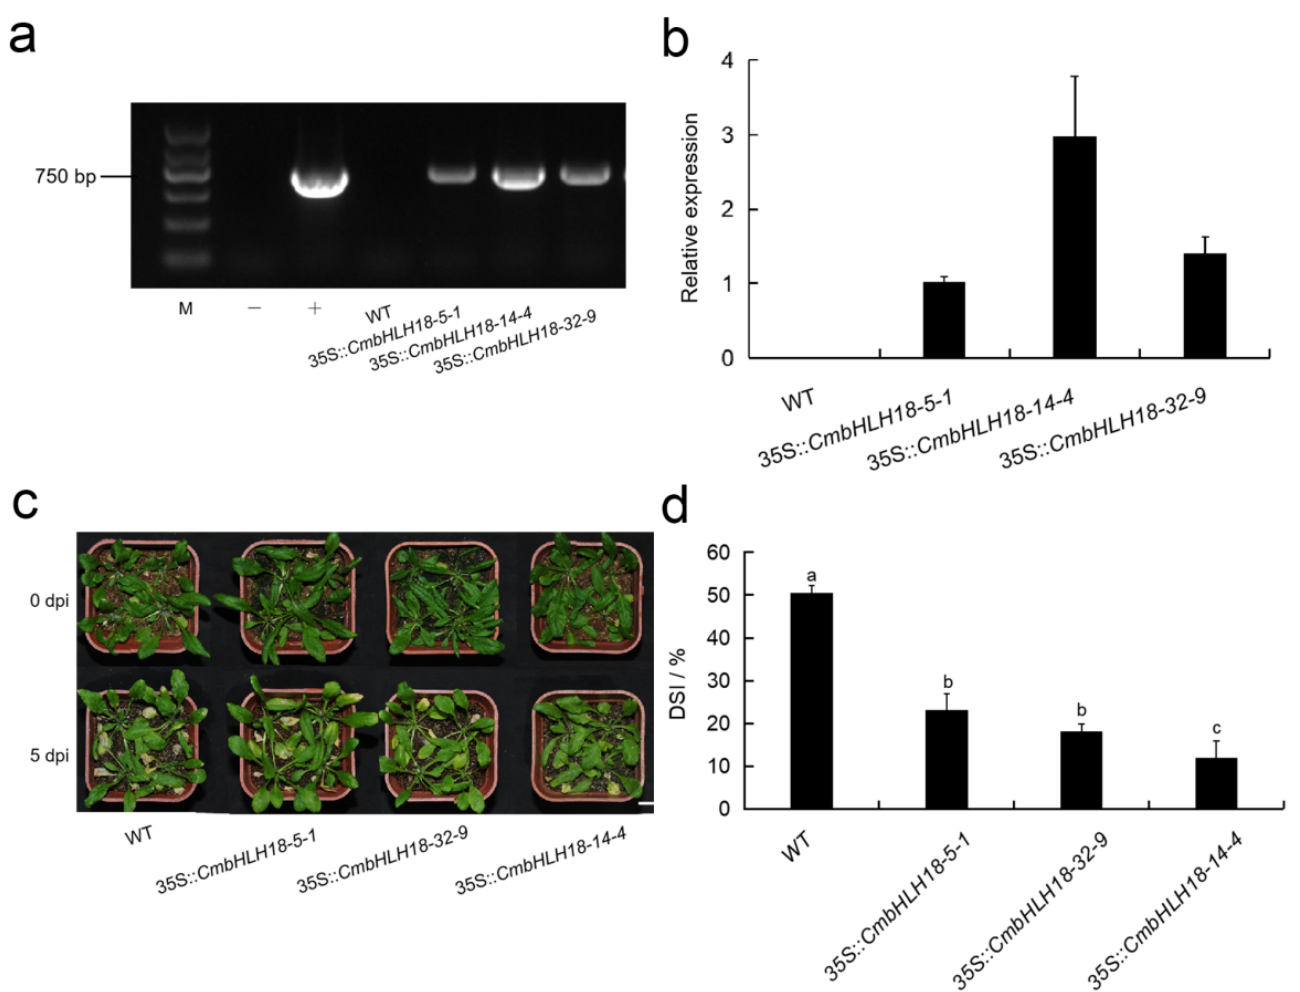
Figure 4. Identification of CmbHLH18 -transformed Arabidopsis plants and morphology and DSI statistics. ( a , b ) PCR and RT-qPCR detection of CmbHLH18 in transformed Arabidopsis . M: DNA DL2000 Marker; ( c ) Morphologic change of CmbHLH18 transformed Arabidopsis lines after A. brassicicola inoculation (Bar = 1 cm); ( d ) DSI of different Arabidopsis lines at 5 dpi. The different letters signified significant differences at p < 0.05 by one-way ANOVA.